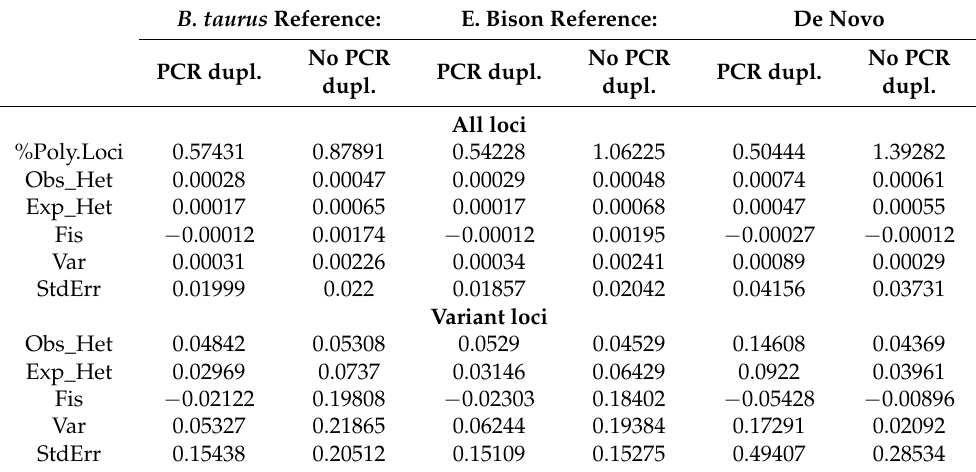
Table 3. Population statistics calculated for all loci using different pipelines: reference pipeline ( Bos taurus ( B. taurus ), European bison (E. bison)), and de novo, with and without PCR duplicates (PCR dupl. and no PCR